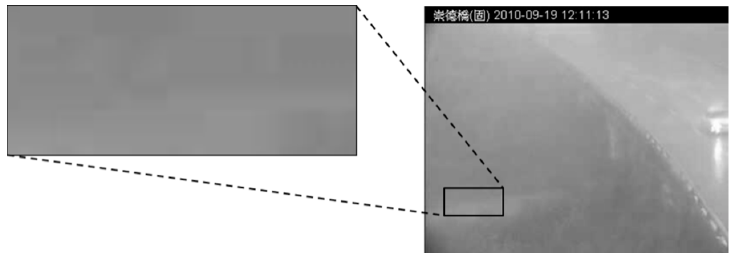
Figure 17. Fog example. Fog and haze regress pixel intensity. (Note: The Traditional Chinese in header of all images is represented the location in the Changed Bridge except). of all images is represented the location in the Changed